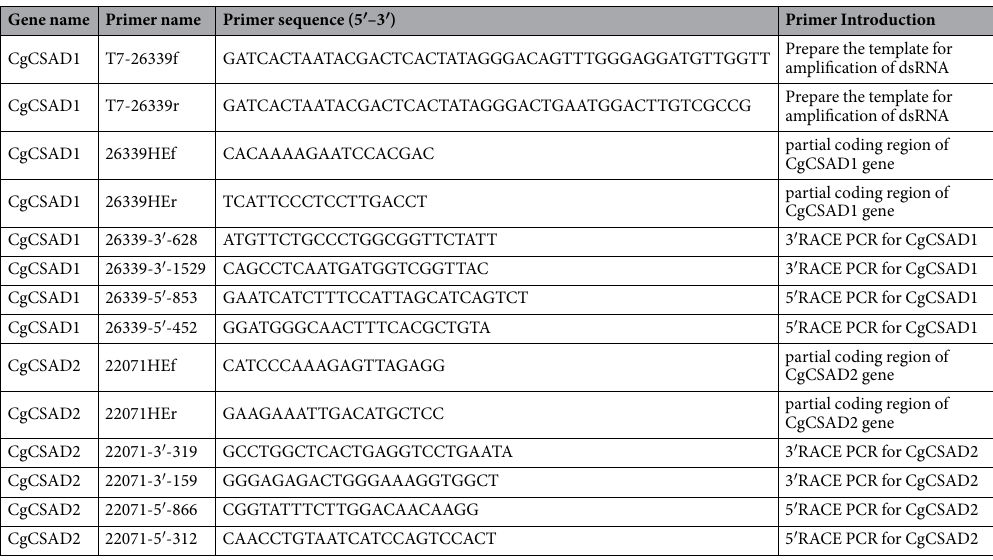
Table 1. The primer used in clone and RNA